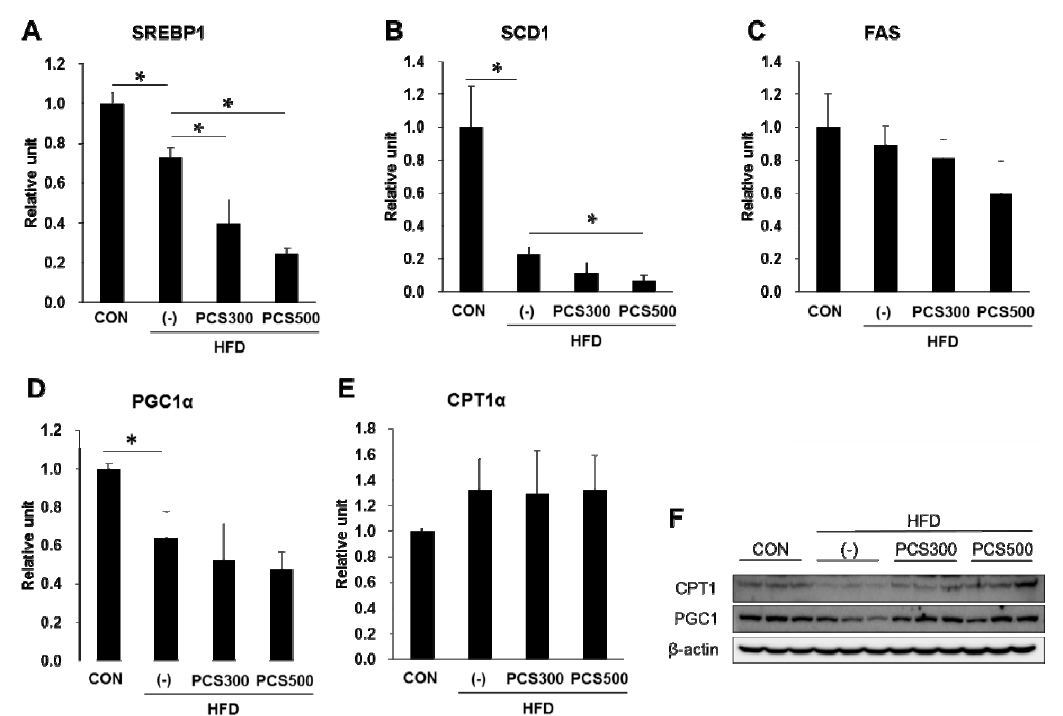
Figure 5. Effect of PCS extract on mRNA and protein expression of lipid metabolism in liver. Mice were fed with regular chow diet (CON) or HFD for 12 weeks. HFD-fed mice were treated with vehicle ( − ) or PCS extract (300 or 500 mg/kg/day) from the first day of HFD feeding ( n = 7–10/group). After 12 weeks of PCS extract treatment, total RNA was extracted from the liver tissue and qRT-PCR analysis was performed for ( A ) sterol regulatory element binding protein (SREBP1) ; ( B ) stearoyl-coenzyme A desaturase (SCD1) ; ( C ) fatty acid synthase (FAS) ; ( D ) proliferator-activated receptor γ coactivator (PGC1 α ) ; and ( E ) carnitine palmitoyltransferase (CPT1 α ) ; ( F ) Total protein was prepared and Western blotting analysis was carried out for CPT1 and PGC1 . * p < 0.05 vs. vehicle-treated HFD-fed mice.